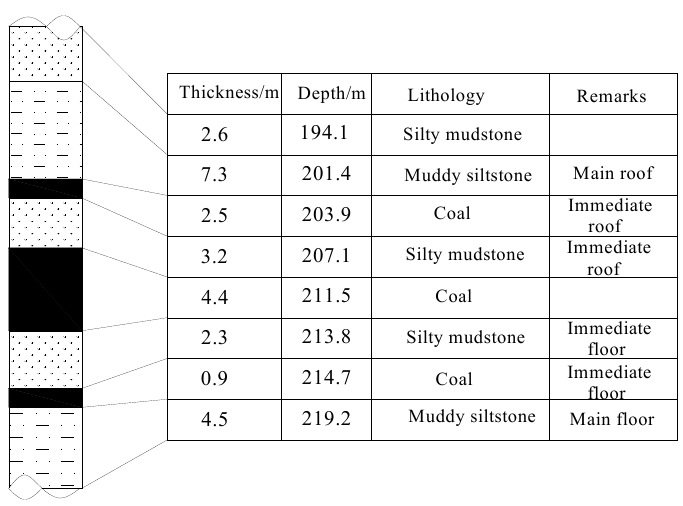
Figure 7. The layout of panels.